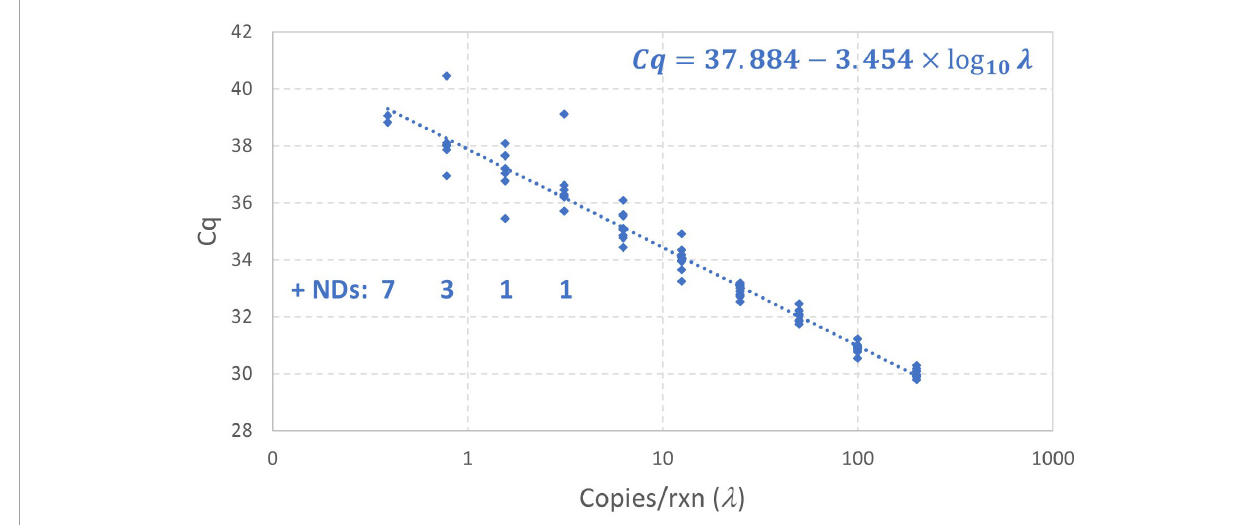
FIGURE7 Empirical standard curve data for synthetic N1 target of SARS-CoV-2 using nine technical replicates at each two-fold dilution between 0.39 and 200 gc/rxn. The log-linear regression standard curve model fitted by the instrument software is shown.